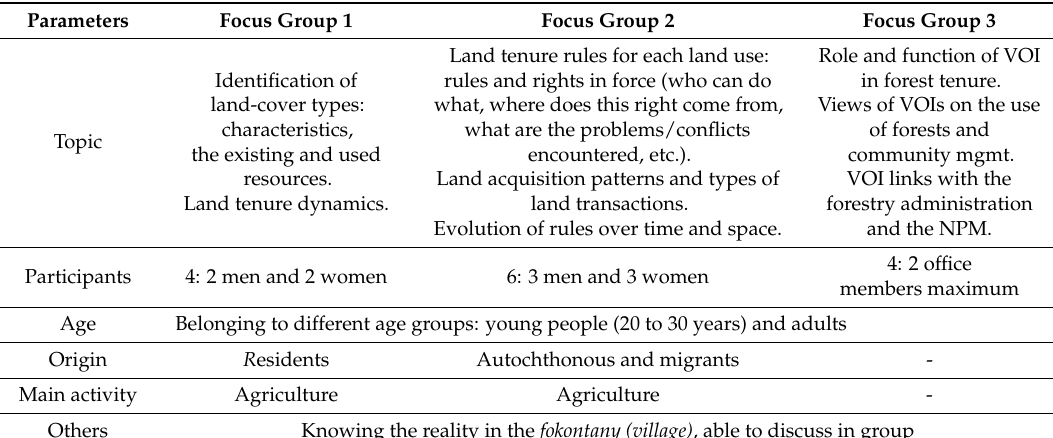
Table A1. Details on the focus groups (FG) of the diagnostic phase. VOI means vondron’olona ifotony, being an association of rural stakeholders involved in natural resource management.